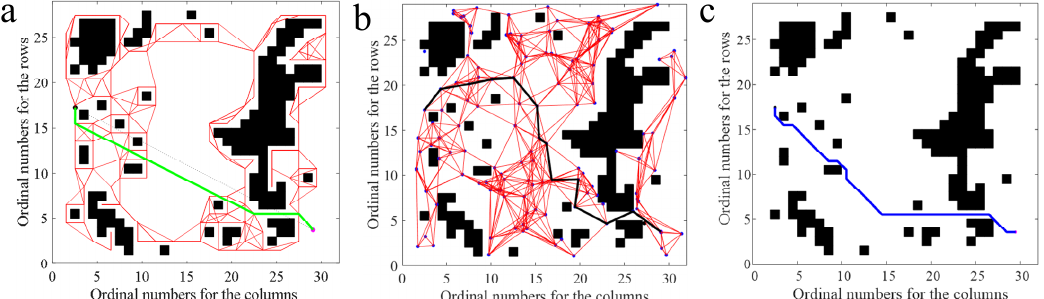
Figure 23. One of the path planning results. ( a ) The green line is the planned path using the sampling ‐ based path planning method under linear guidance. ( b ) The black line is the planned path using the standard PRM method. ( c ) The blue line is the planned path using A* search algorithm.